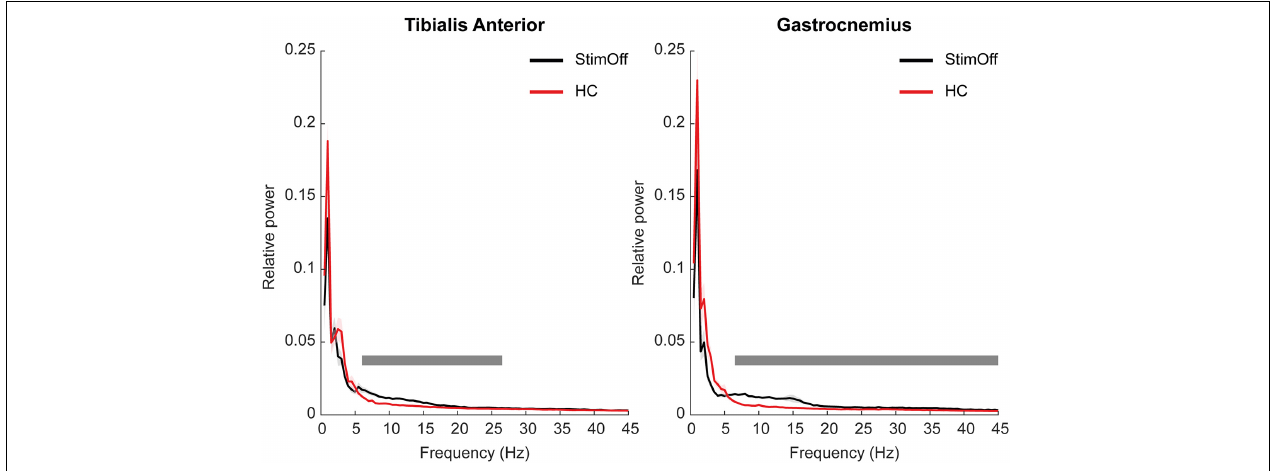
FIGURE 1 | Power spectrum and standard error of the mean (SEM) of TA ( A, left panel) and GA ( B, right panel) during ‘regular gait’ in 9 PD patients with DBS turned off (’StimOff’) and healthy controls (HC). PD patients in ‘StimOff’ showed higher power of TA in the alpha and low-beta range (6–26.5 Hz; p = 0.0004) and a higher power in the GA muscle (6.5–45 Hz; p = 0.0004, cluster based permutation